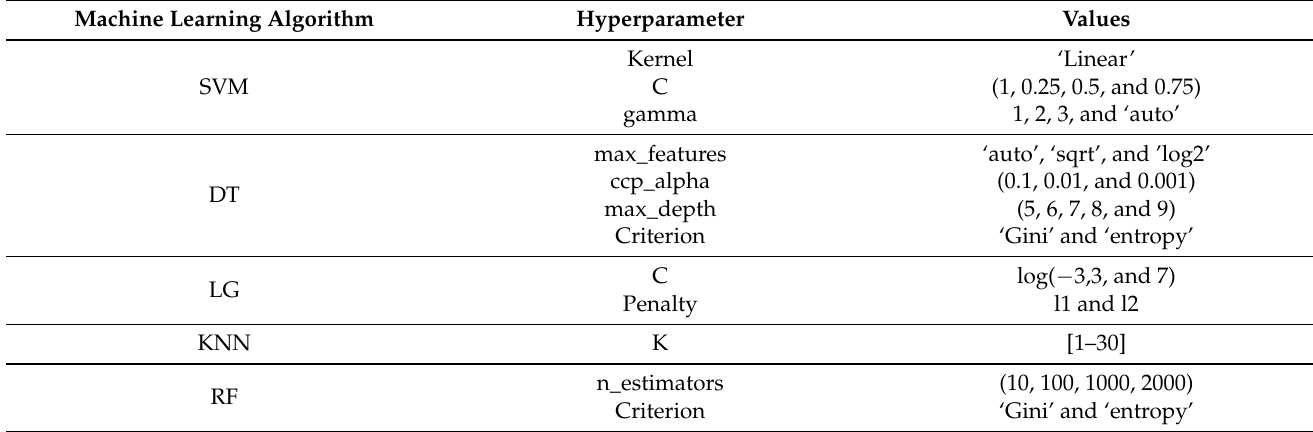
Table 3. The predefined values of hyperparameters for the used supervised machine learning algorithms. Machine Learning